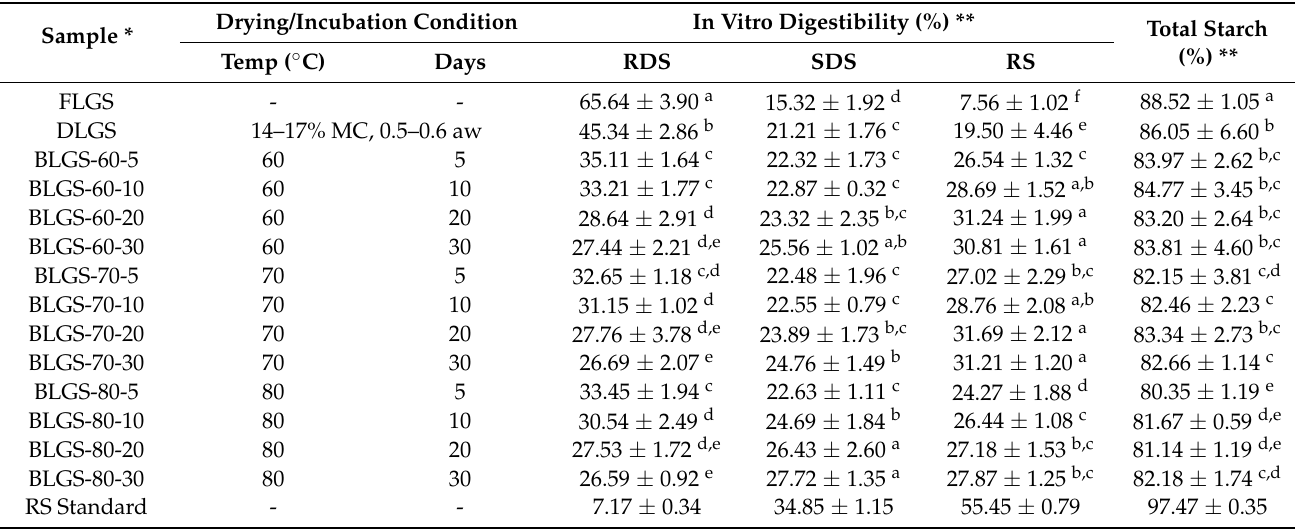
* FLGS—starch from fresh seeds; DLGS—starch from oven-dried seeds; BLGS—starch from incubated seeds. ** All values were reported on a dry basis of starch. Data are mean ± SD. Means within the same column with different letters indicate significant difference ( p ≤ 0.05) by Duncan’s multiple range